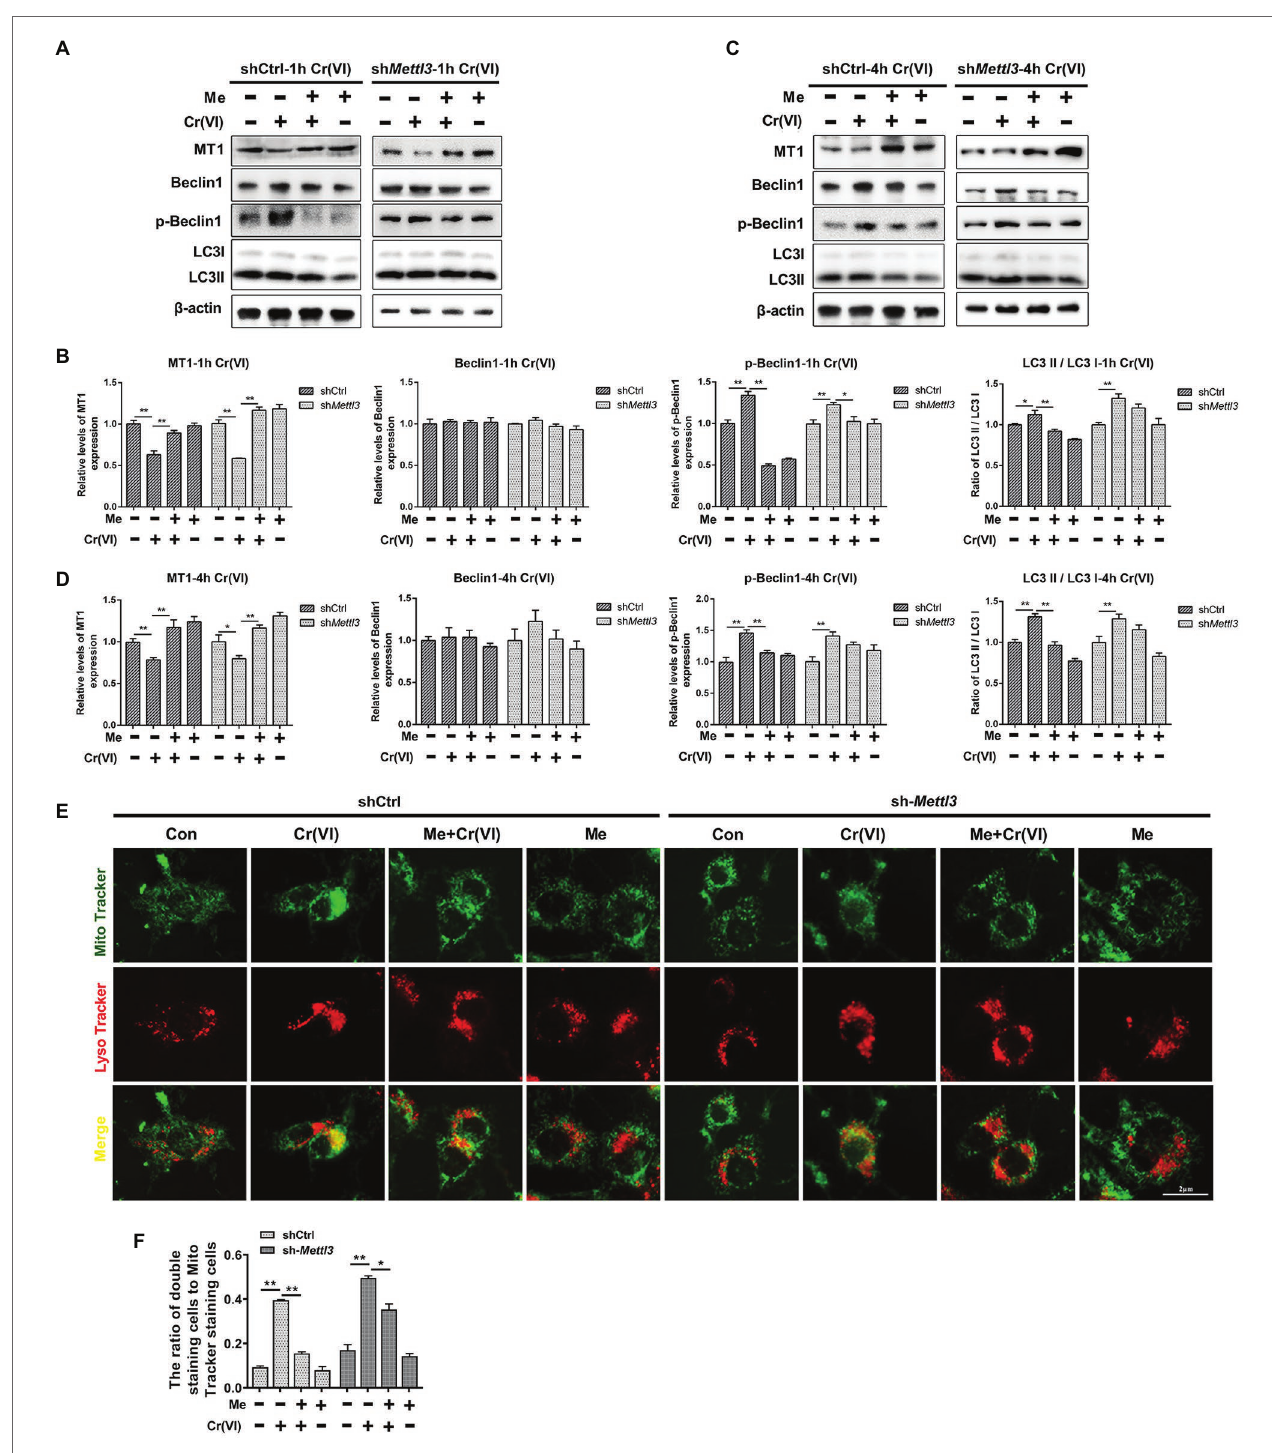
FIGURE 9 | Melatonin attenuated Cr (VI)-induced mitophagy by restoration of METTL3-mediated RNA m 6 A modification in SSCs/progenitors. (A,C) Western blot analysis of MT1, Beclin1, p-Beclin1, and LC3 in the scramble control and Mettl3 -shRNA SSCs/progenitors treated with vehicle, Cr (VI), melatonin + Cr (VI), or melatonin. Of these, Cr (VI) treatment lasted for 1 (A) or 4 h (C) . β -actin is used as a loading control. (B,D) The relative expression of MT1, Beclin1, p-Beclin1, and LC3-II in different cell groups after 1 (B) or 4 h (D) of Cr (VI) treatment. (E) Mito and Lyso Tracker co-staining analysis in the scramble control and Mettl3 -shRNA SSCs/progenitors treated with vehicle, Cr (VI), melatonin + Cr (VI), or melatonin. Of these, Cr (VI) treatment lasted for 4 h. Bar = 2 μ m. (F) The ratios of double staining cells to Mito Tracker staining cells in the scramble control and Mettl3 -shRNA SSCs/progenitors treated with vehicle, Cr (VI), melatonin + Cr (VI), or melatonin. Data are presented as the mean ± SEM of three independent experiments. * p < 0.05; ** p <